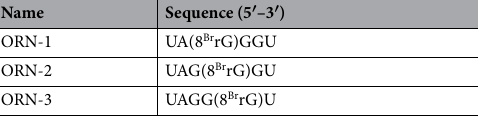
Table 1. RNA sequences used in this study.